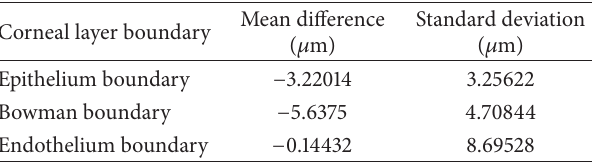
Table 4: Mean and standard deviation of signed error in corneal layer boundary segmentation between automatic and manual seg- mentation using level